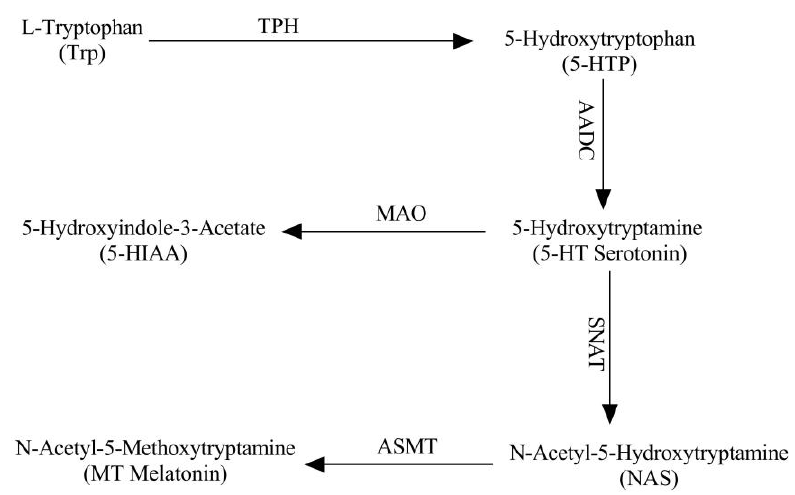
Figure 1. Melatonin synthetic pathway in mammals. TPH: tryptophan hydroxylase, AADC: aryl amino acid decarboxylase, SNAT: serotonin N-acetyltrasferase, ASMT: N-acetyltraptamine methyl- trasferase, MAO: monoamine oxidase.